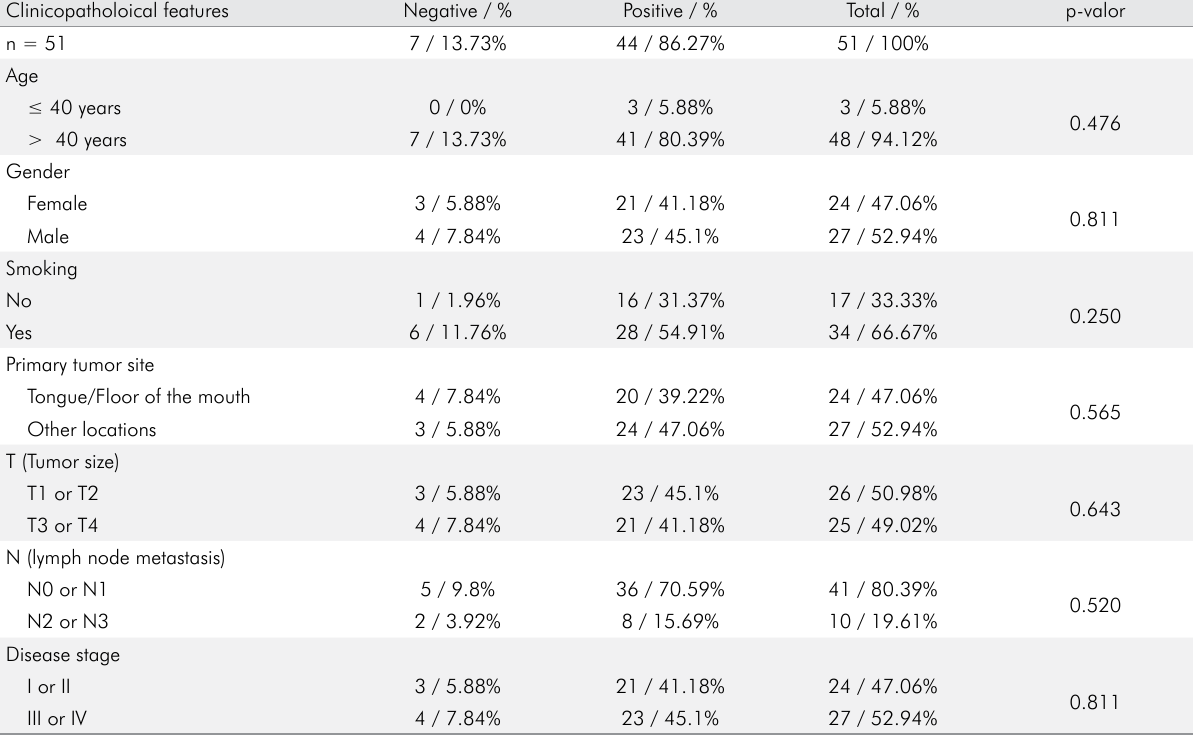
Table 2. Association between MCM3 immunostaining and clinicopathological